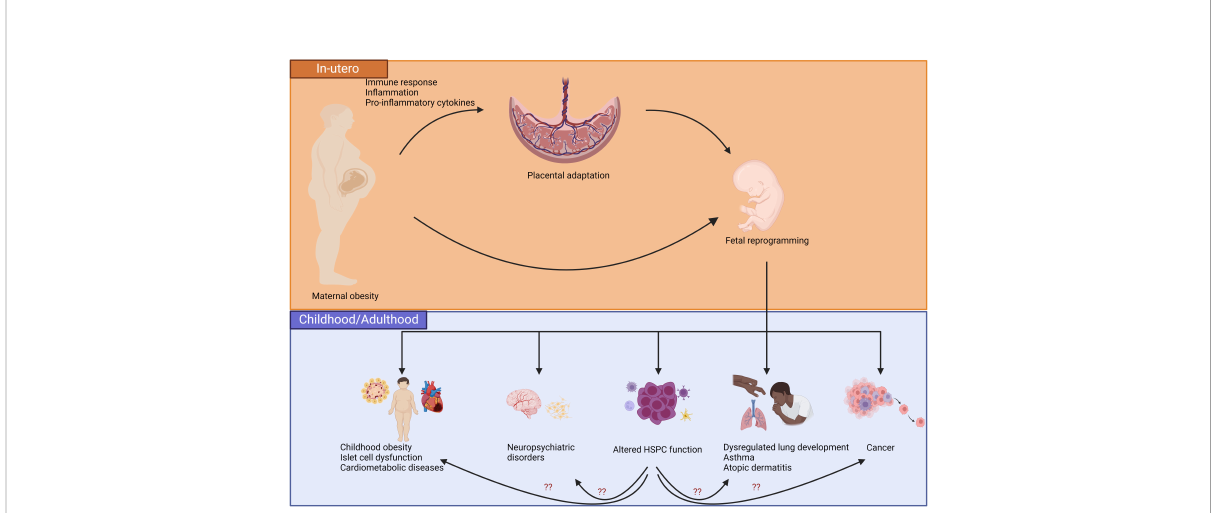
FIGURE 2 Proposed model of the effects ofmaternal obesity onplacental adaptationand fetal reprogramming that led to endorgan changes and adverse health outcomes in children. Placenta showsadaptationto environmental stressorsincludingmaternal obesity-associated in fl ammatorystate.Changes in placenta predisposesthe fetus to reprogramming that is associated with a higher risk of childhood obesity,neuropsychiatric disorders, altered HSPC function, atopic diseases, dysregulated pulmonary development,and/or cancer.Altered HSPC functionand the immune cells that originate fromthe HSPCs may further predispose children to adverse health outcomes associated with maternal obesity.Created with